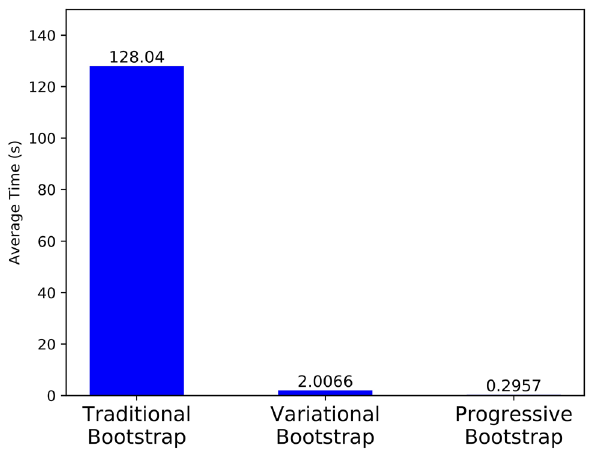
Fig. 6 Performance on different data